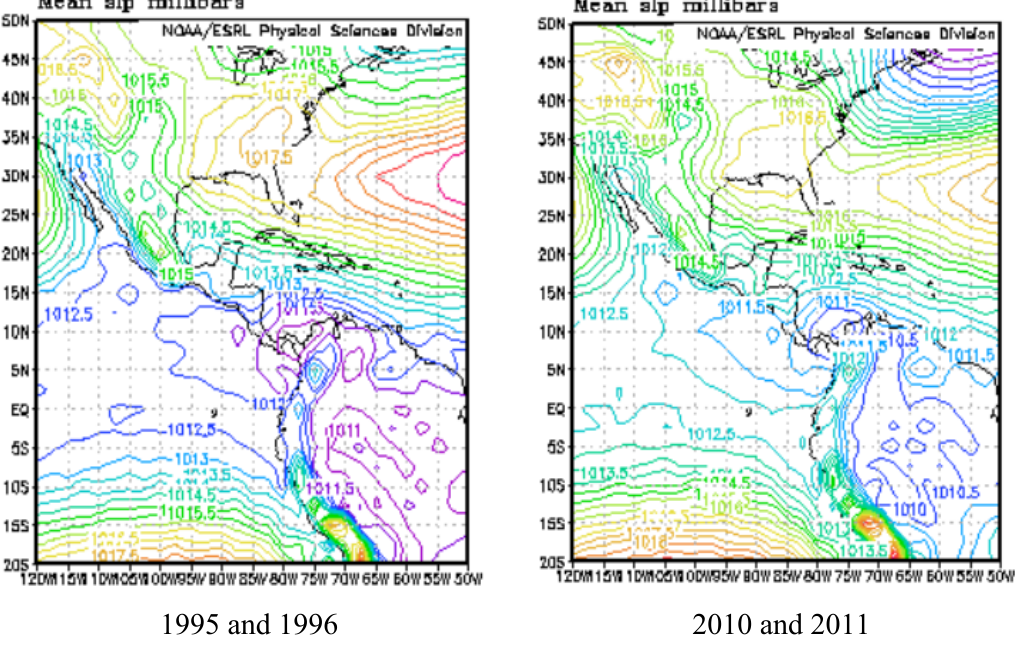
Figure 12. National Center for Environmental Prediction (NCEP) reanalysis mean sea-level pressure for March-October in 1995 and 1996 and 2010 and